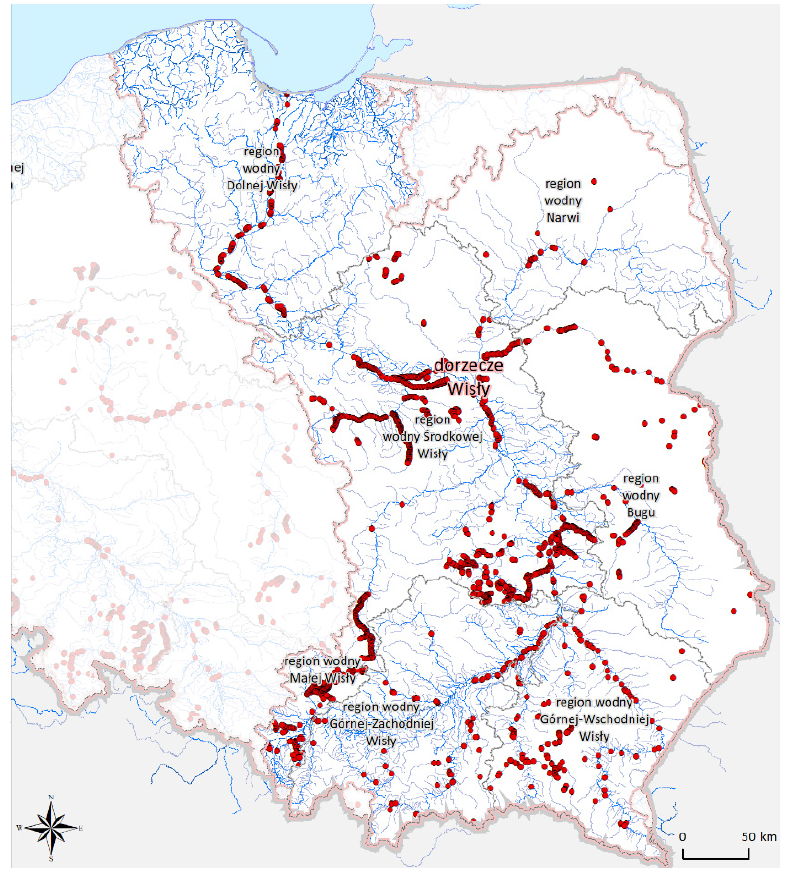
Figure 7. Possible locations of past ice-jam events along the Vistula River and its tributaries (second update of the river basin management plans).